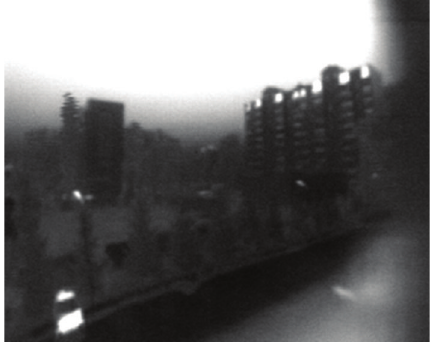
Figure 6: KUT25 WSS starting image.